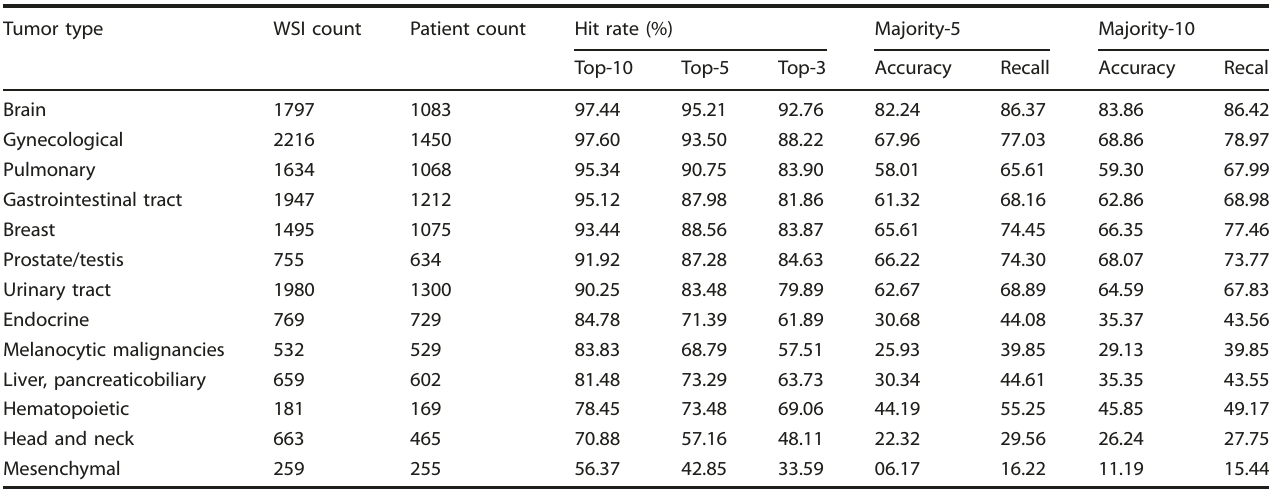
Table 1. Results for cancer-type recognition (horizontal search) among frozen slides.